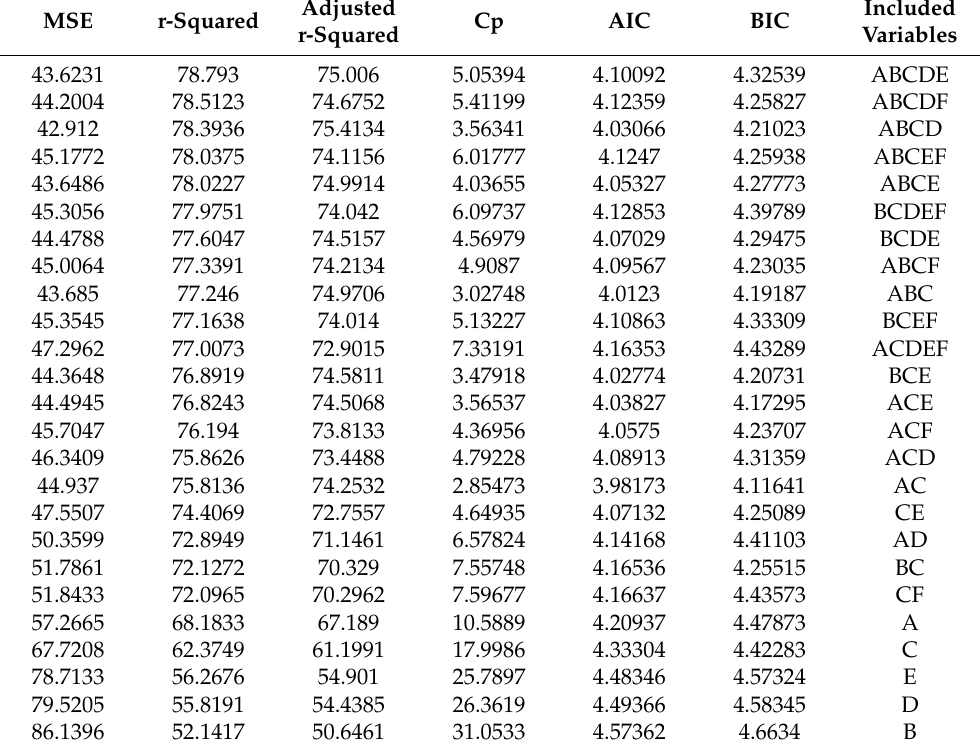
Table 6. Models with Larger Adjusted